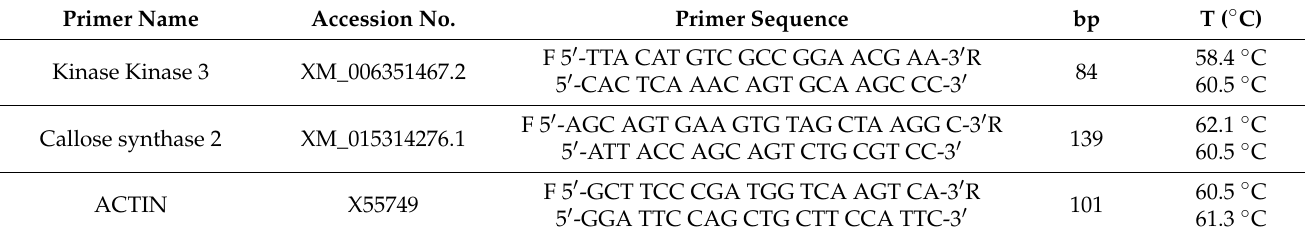
Table 1. Kinase kinase 3, Callose synthase and the reference gene (ACT) for QRT-PCR. Primer